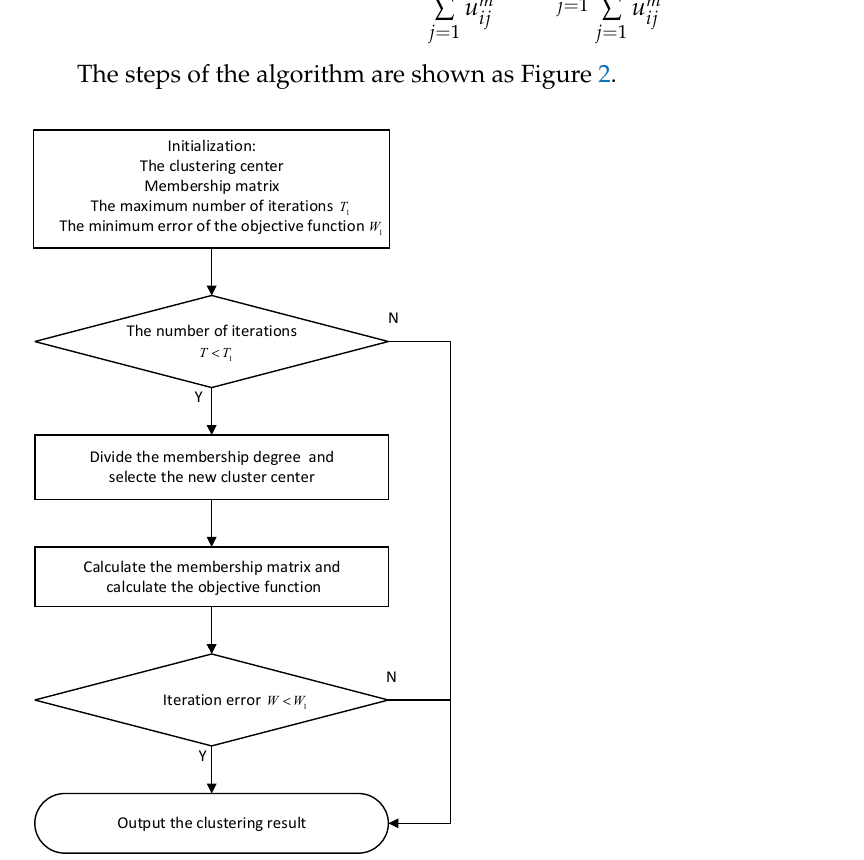
Figure 2. Flow chart of the FCM clustering algorithm.